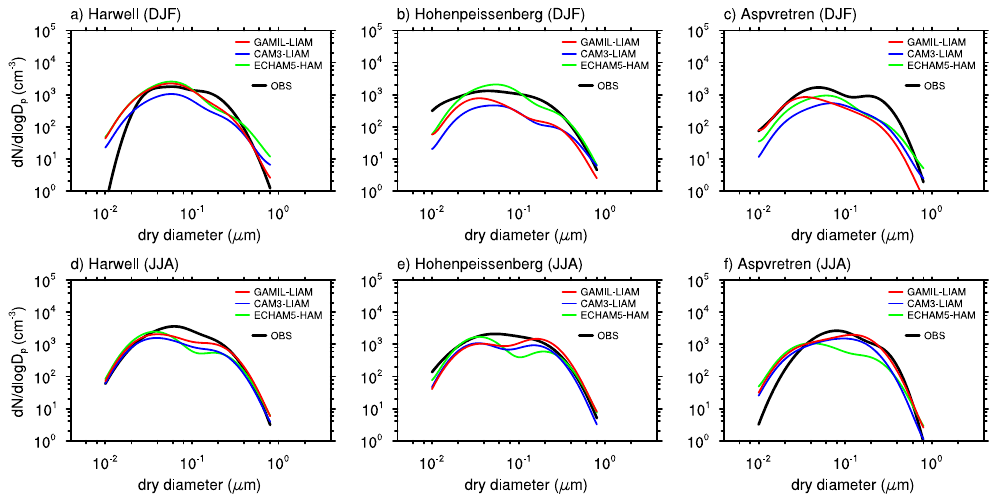
Fig. 11. Comparison between the simulated and observed aerosol size distributions in the continental and coastal boundary layer over Europe. The observations were compiled by Putaud et al. (2003) (see Appendix 3